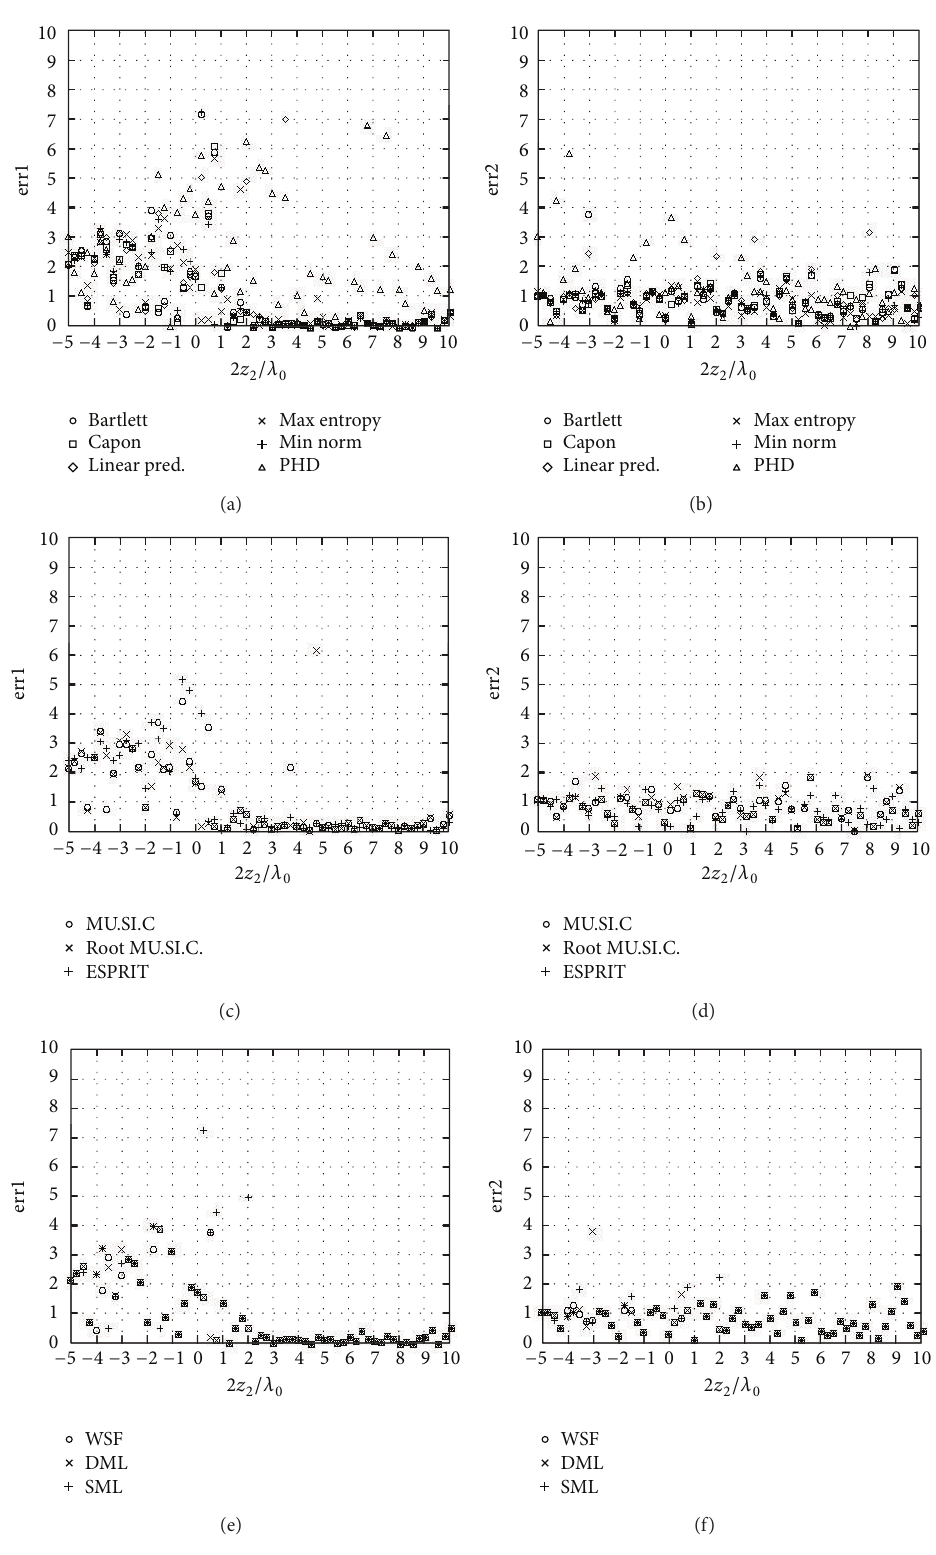
Figure 5: Localization of a cavity (𝜀 𝑟1 = 1) and a dielectric cylinder (𝜀 𝑟2 = 9) , both having a radius equal to 𝜆 0 . All the other parameters are the same as in the previous